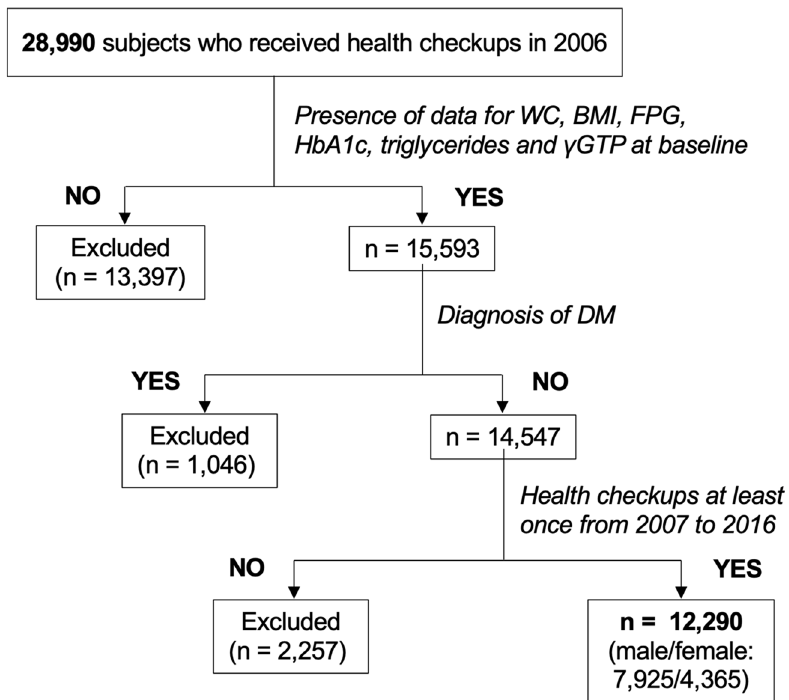
Figure 1. Flow chart of the selected study participants. Among 28,990 subjects enrolled in 2006, a total of 12,290 subjects (male/female: 7925/4365) were finally recruited for analyses in the present study. BMI body